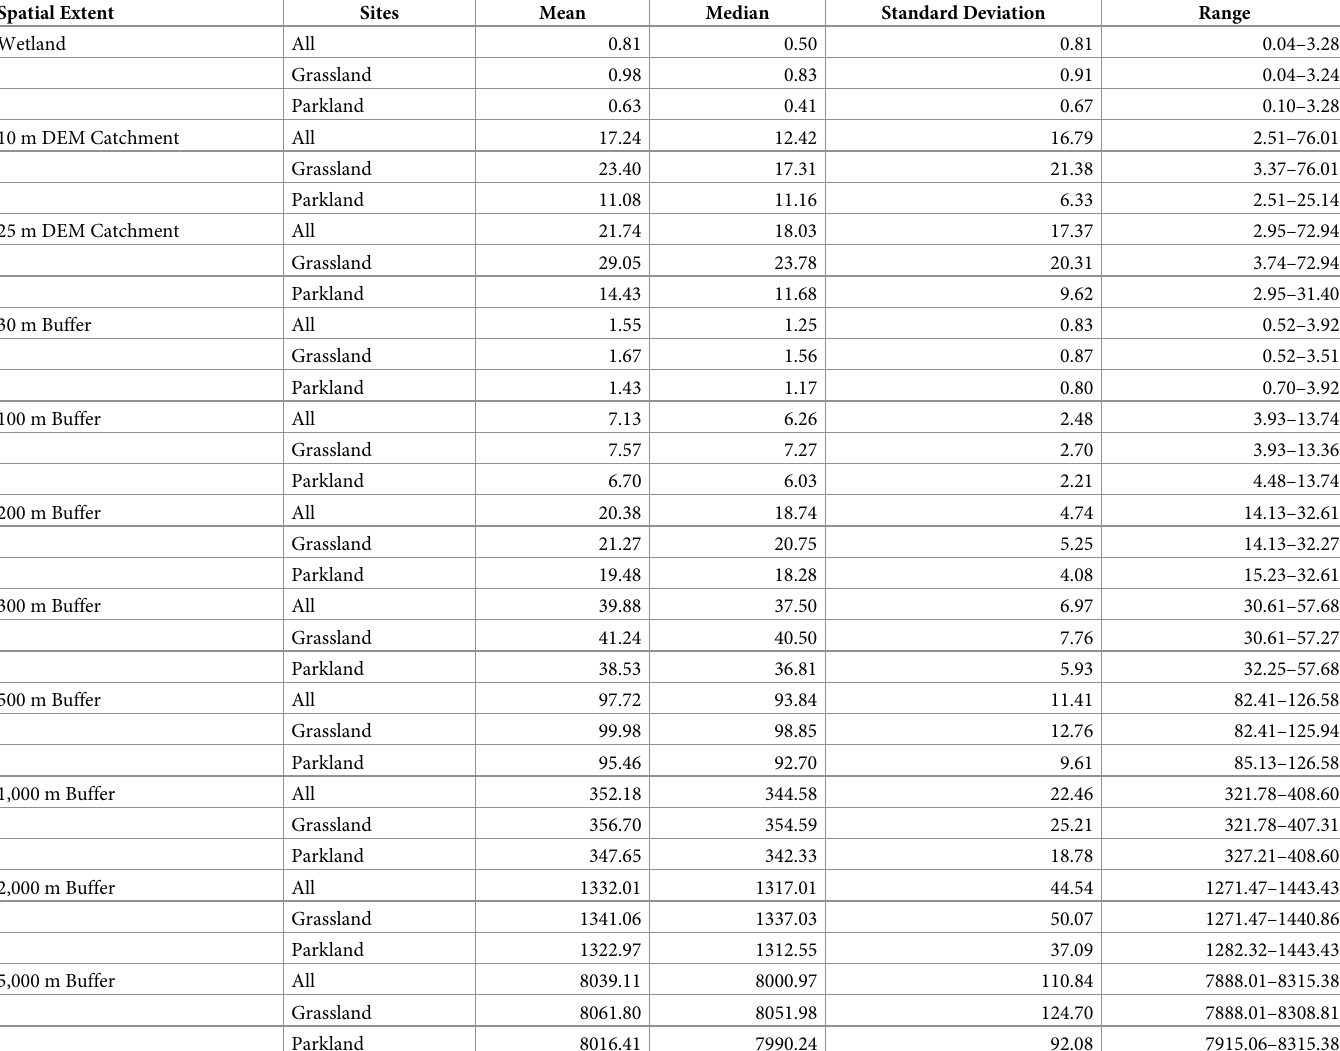
Table 1. Summary statistics of the size of wetlands and the ten spatial extents used to extract land-cover data around each wetland for all study sites ( n = 48) and for wetlands in the Grassland ( n = 24) and Parkland ( n = 24) natural regions separately. Units for all values are hectares. Spatial